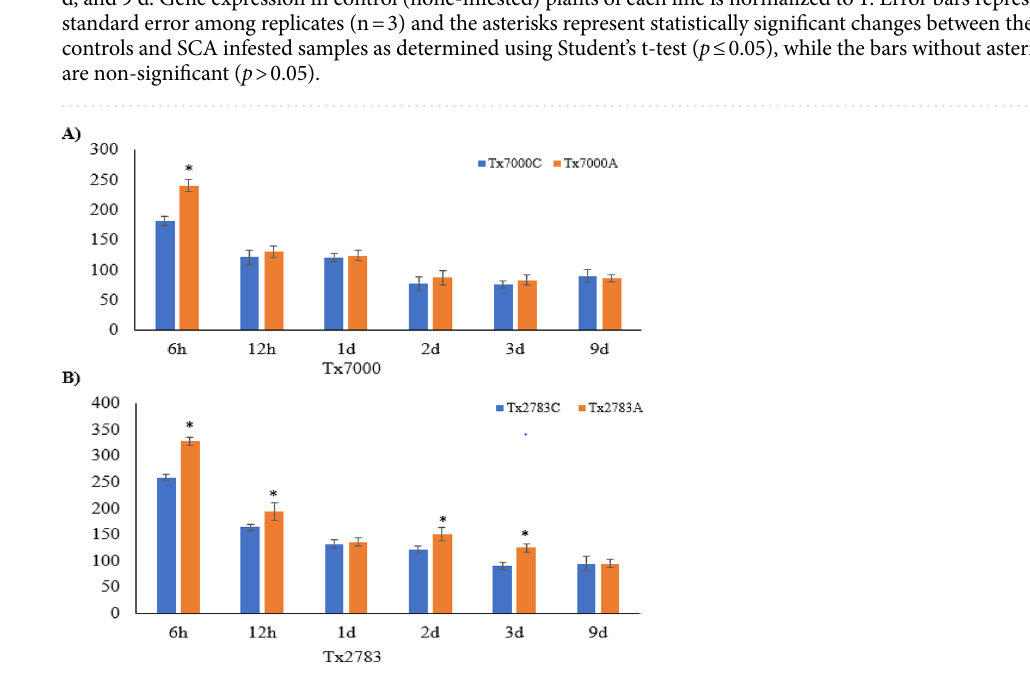
Figure 4. Comparison of the PAL activities between sugarcane aphid (SCA) infested sorghum plants and in the controls at various time points after exposure to SCA, and also the PAL activities shown in susceptible genotype Tx7000 ( A ) and resistant genotype Tx2783 ( B ), respectively. Error bars represent standard error among replicates. The asterisks represent statistically significant changes between the controls and SCA infested plants as determined using Student’s t-test ( p ≤